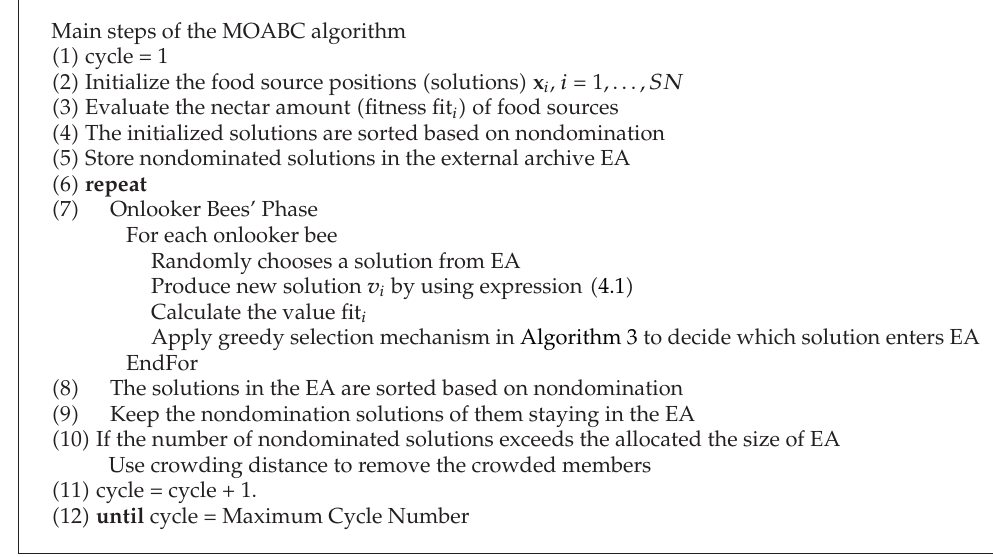
Algorithm 2: Pseudocode for MOABC